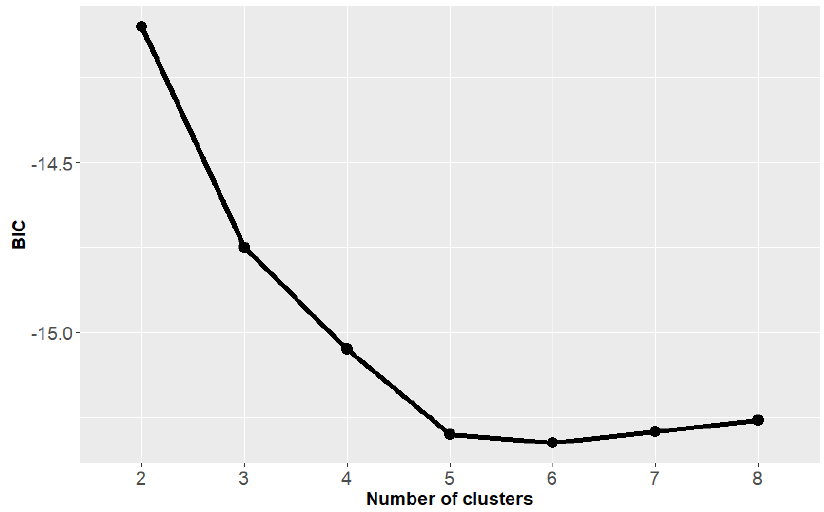
Figure 3. Bayesian information criterion (BIC) (10ˆ5) variation for GMM with the number of clusters.